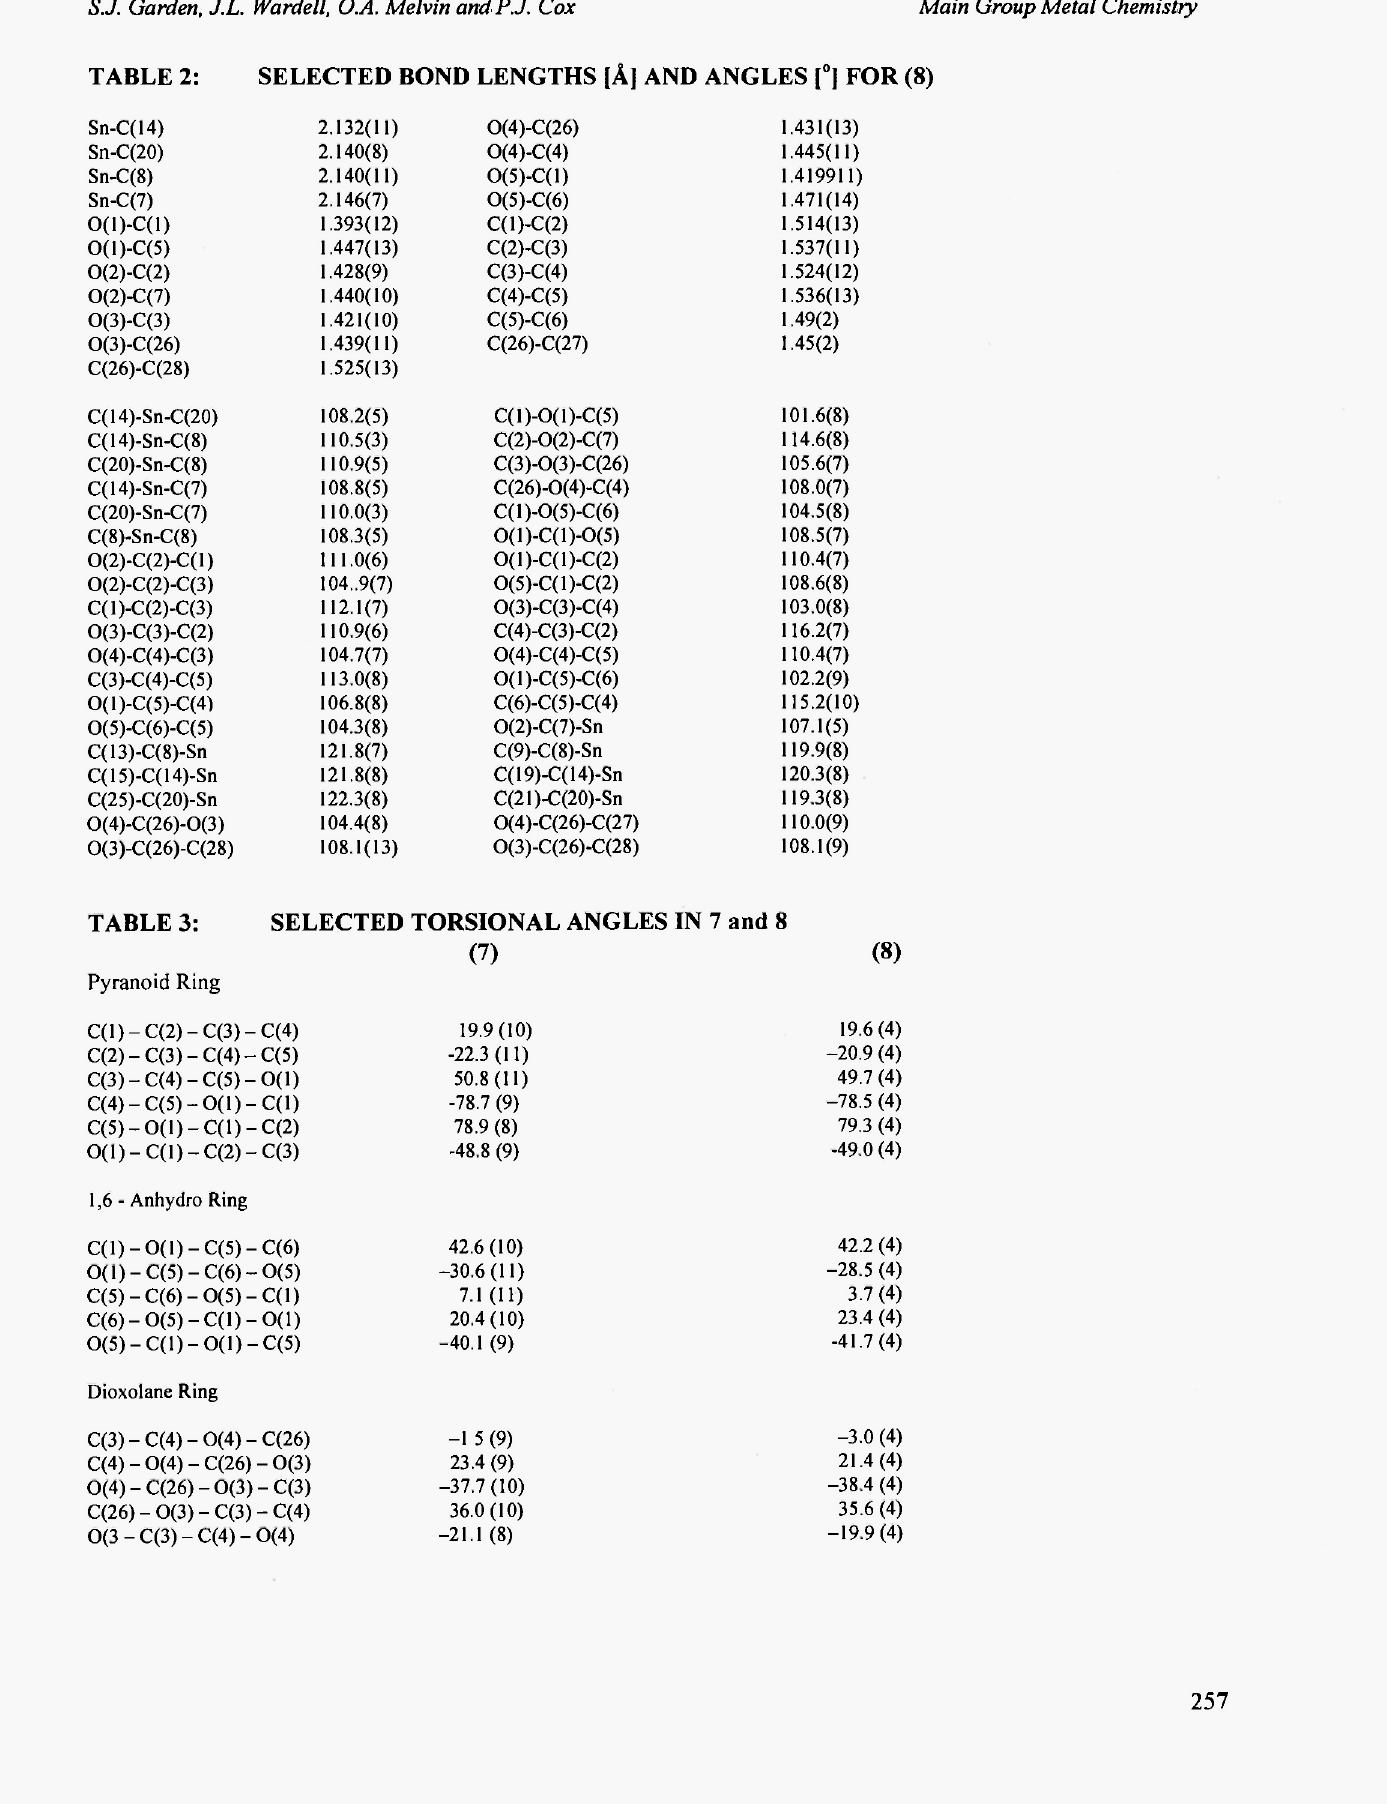
SELECTED BOND LENGTHS [Ä] AND ANGLES [°] FOR (8)